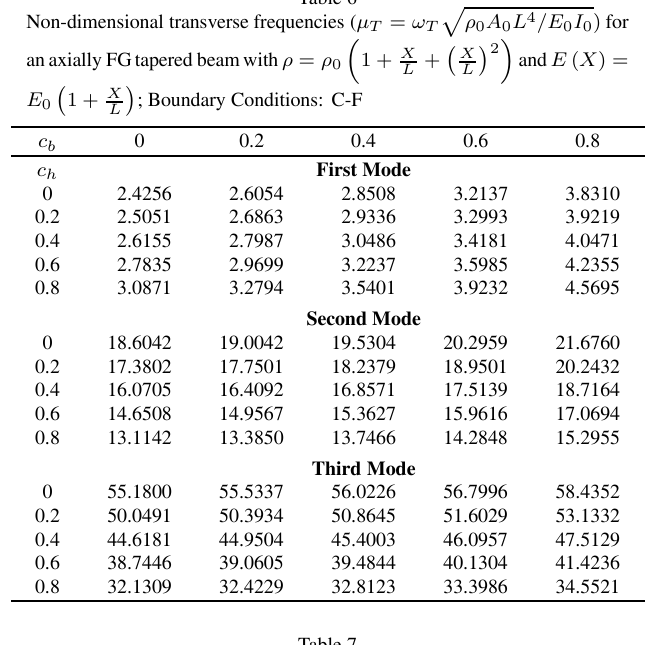
Non-dimensional transverse frequencies ( μ T = ω T for an axially FG tapered beam with ρ = ρ